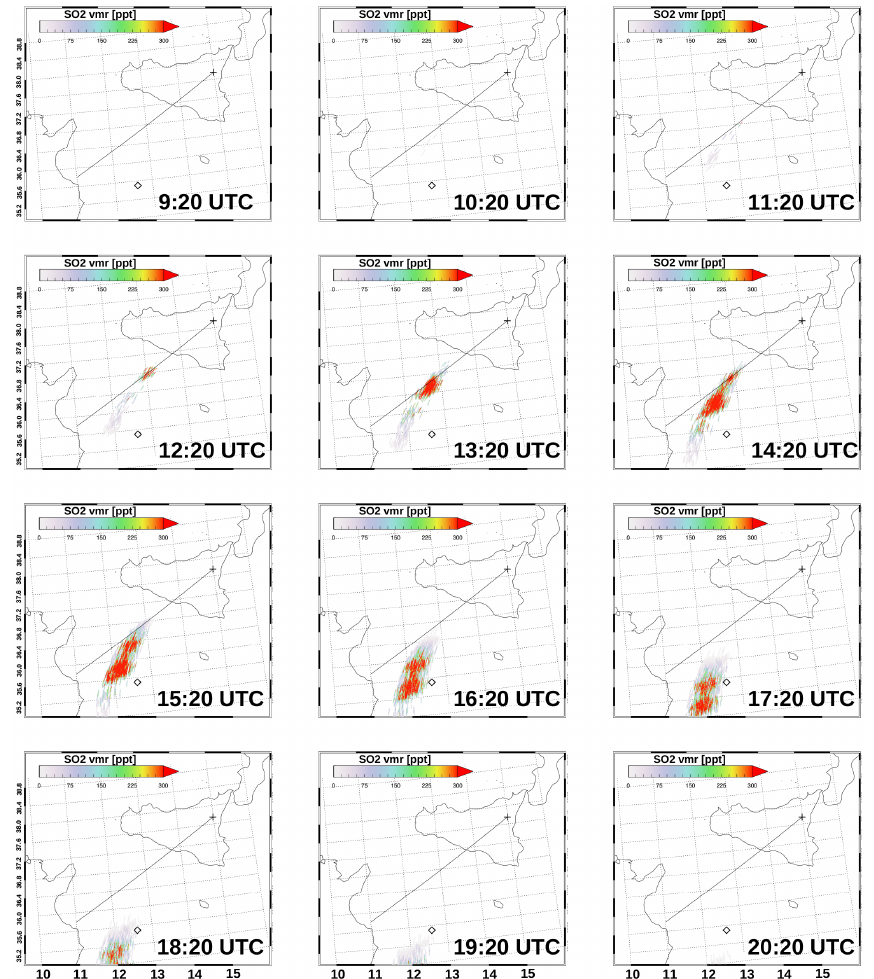
Figure 7. Mean SO 2 volume mixing ratio (in ppt) in the altitude range from 10 to 14km, from FLEXPART simulations, for 26 October 2013 from 09:20 to 20:20 (1h time step, times indicated in the figure panel). Violet–grey to red pixels indicate relatively low to high mixing ratio values. The position of Lampedusa is indicated with a black diamond; the position of Mount Etna is indicated with a black